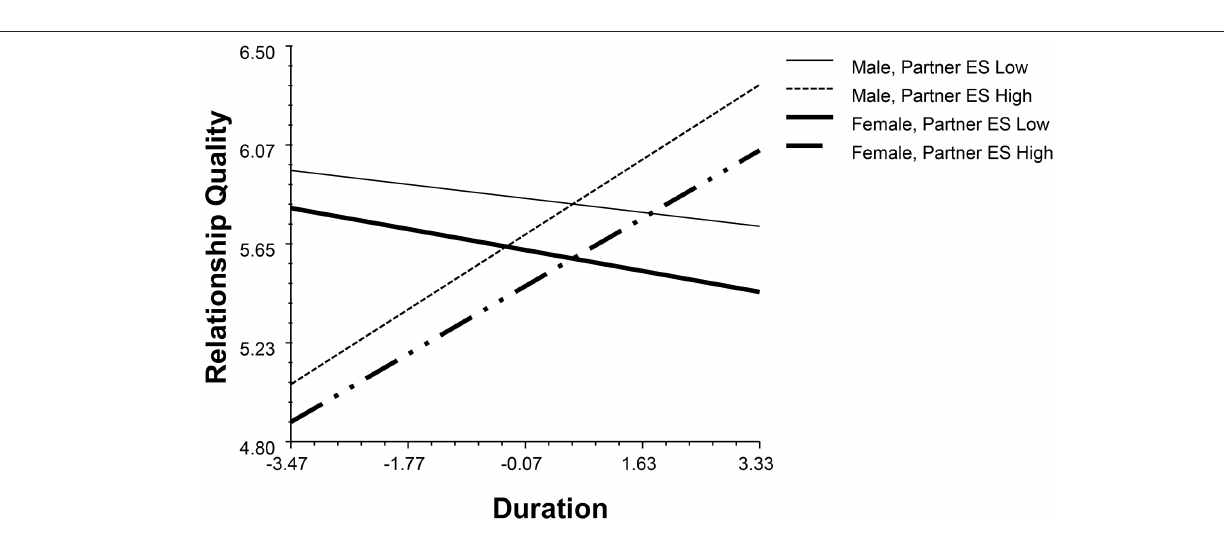
FIGURE 2 | The interaction between partner’s emotional stability, gender and